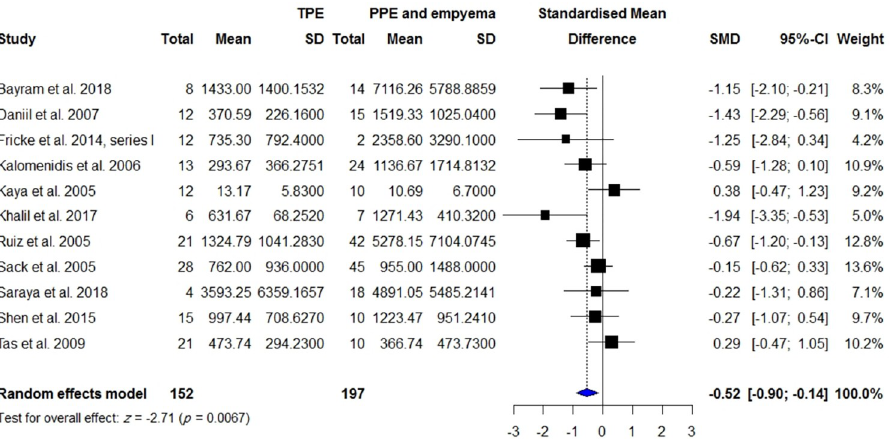
Fig 11. Meta-analysis of pleural VEGF levels in patients with TPE vs. patients with empyema and PPE.